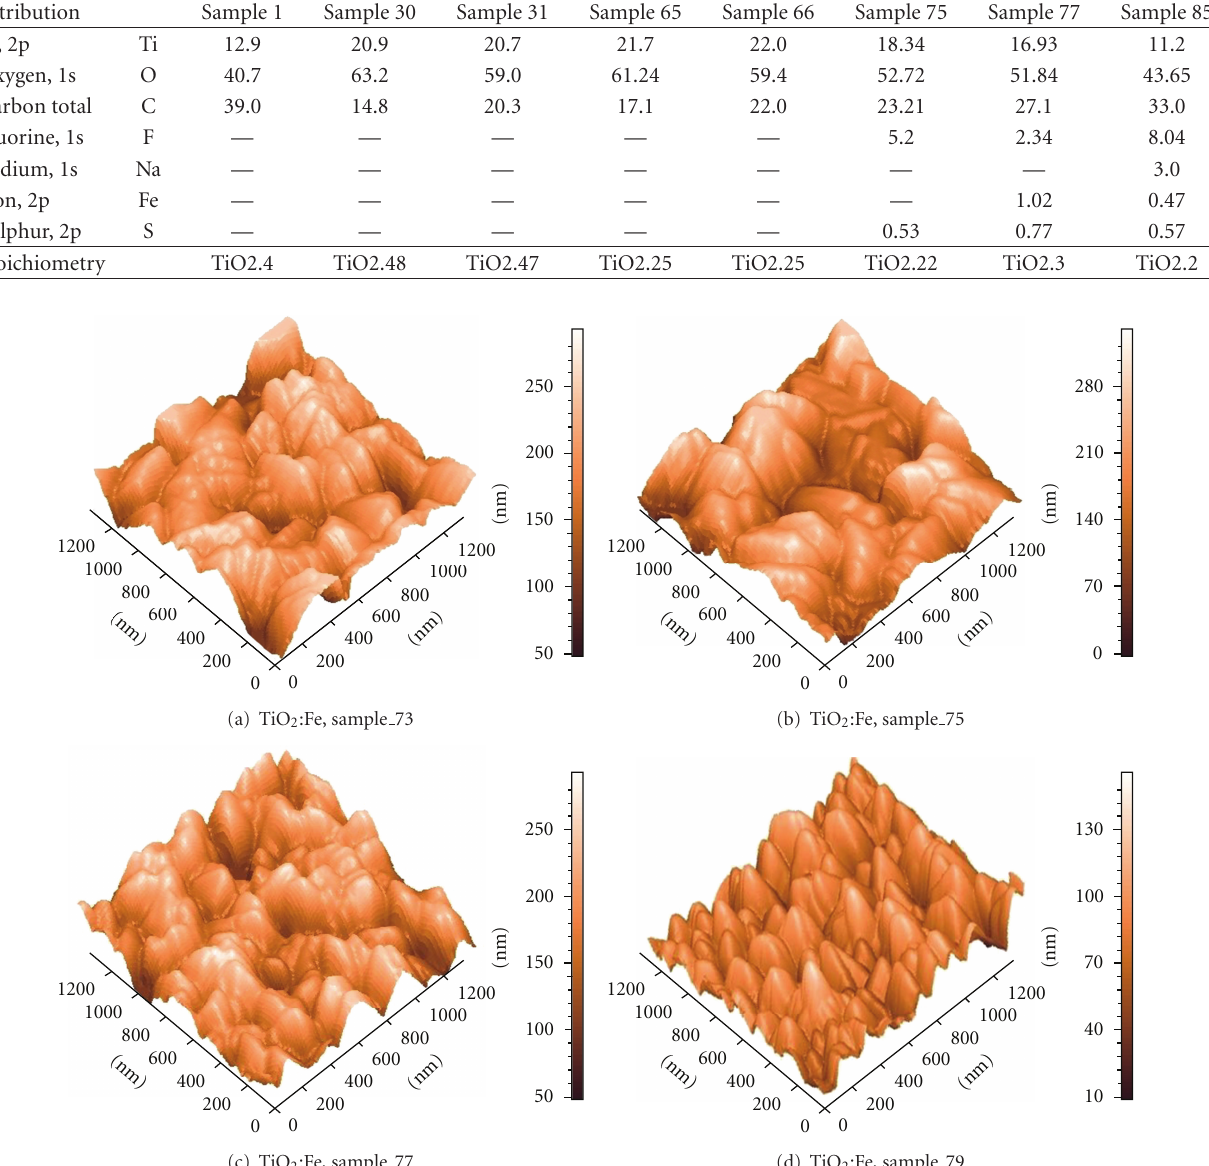
Figure 5: The AFM image of the samples with the thin film thickness 600–1000 nm (the field size is 1.2 μ m by 1.2 μ m; the shades of grey correspond to the vertical scale of the recording of 0 to 250 nm). Samples 73–77 (internal evaporator), sample 79, (external